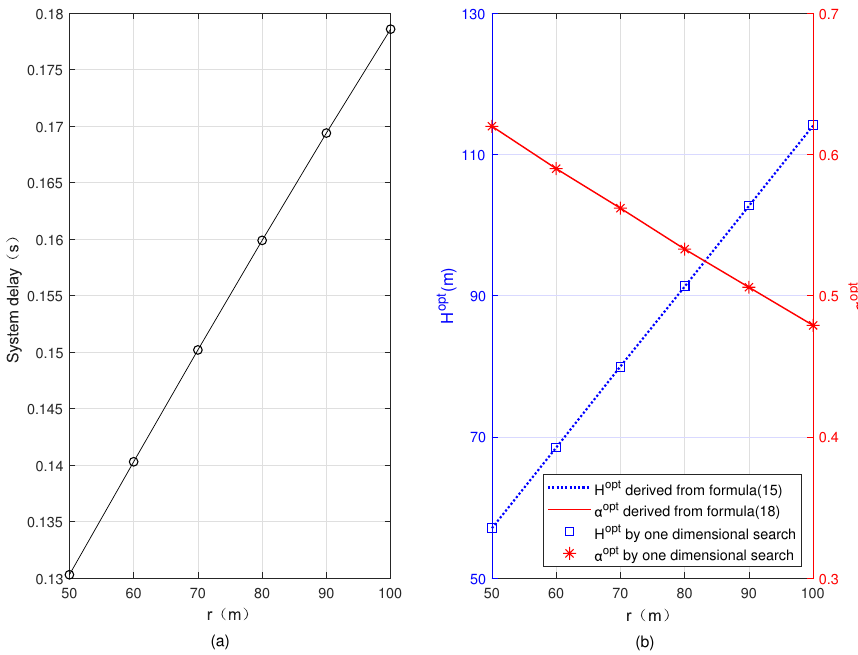
Figure 6. Minimum system delay, optimal flying altitude, and optimal task allocation ratio versus the distance between the UAV’s projection on the ground and the user. ( a ) Minimum system delay, ( b ) optimal flying altitude and optimal task allocation